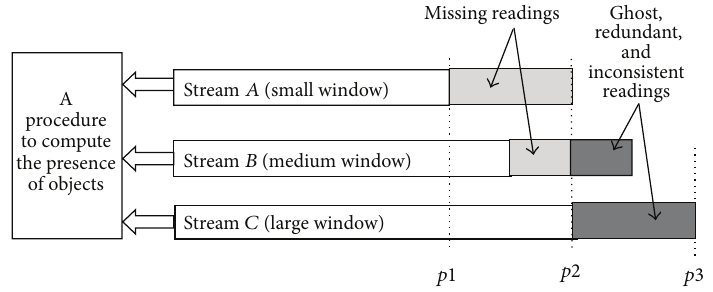
Figure 3: Using three different smoothing windows for reading RFID